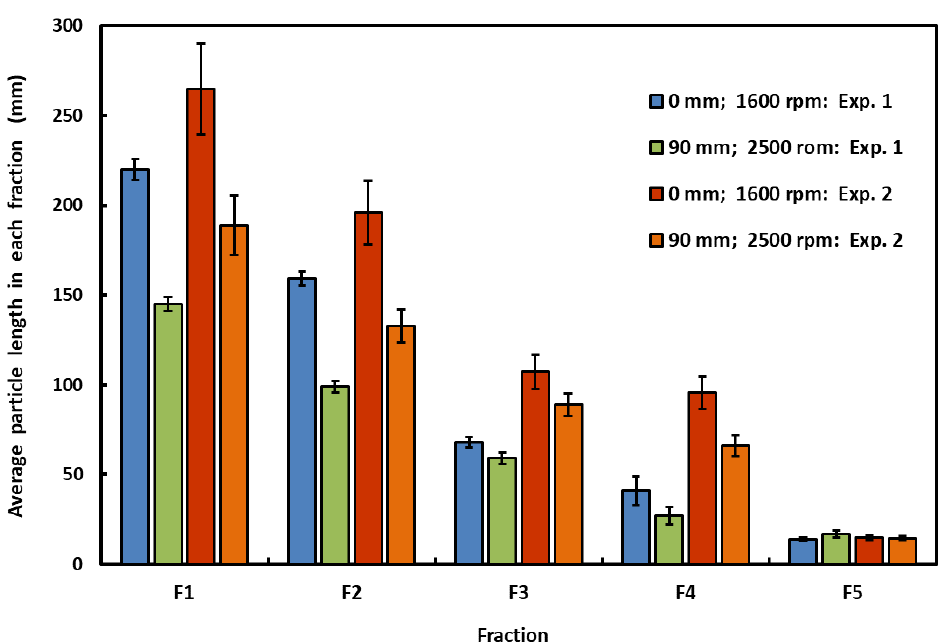
Figure 8. Average hand-measured particles from fractions F1 through F5 for Experiments 1 and 2 for two stationary knife engagements (0 or 90 mm) and two residue chopper speeds (1600 or 2500 rpm). Error bars represent standard error of the mean.